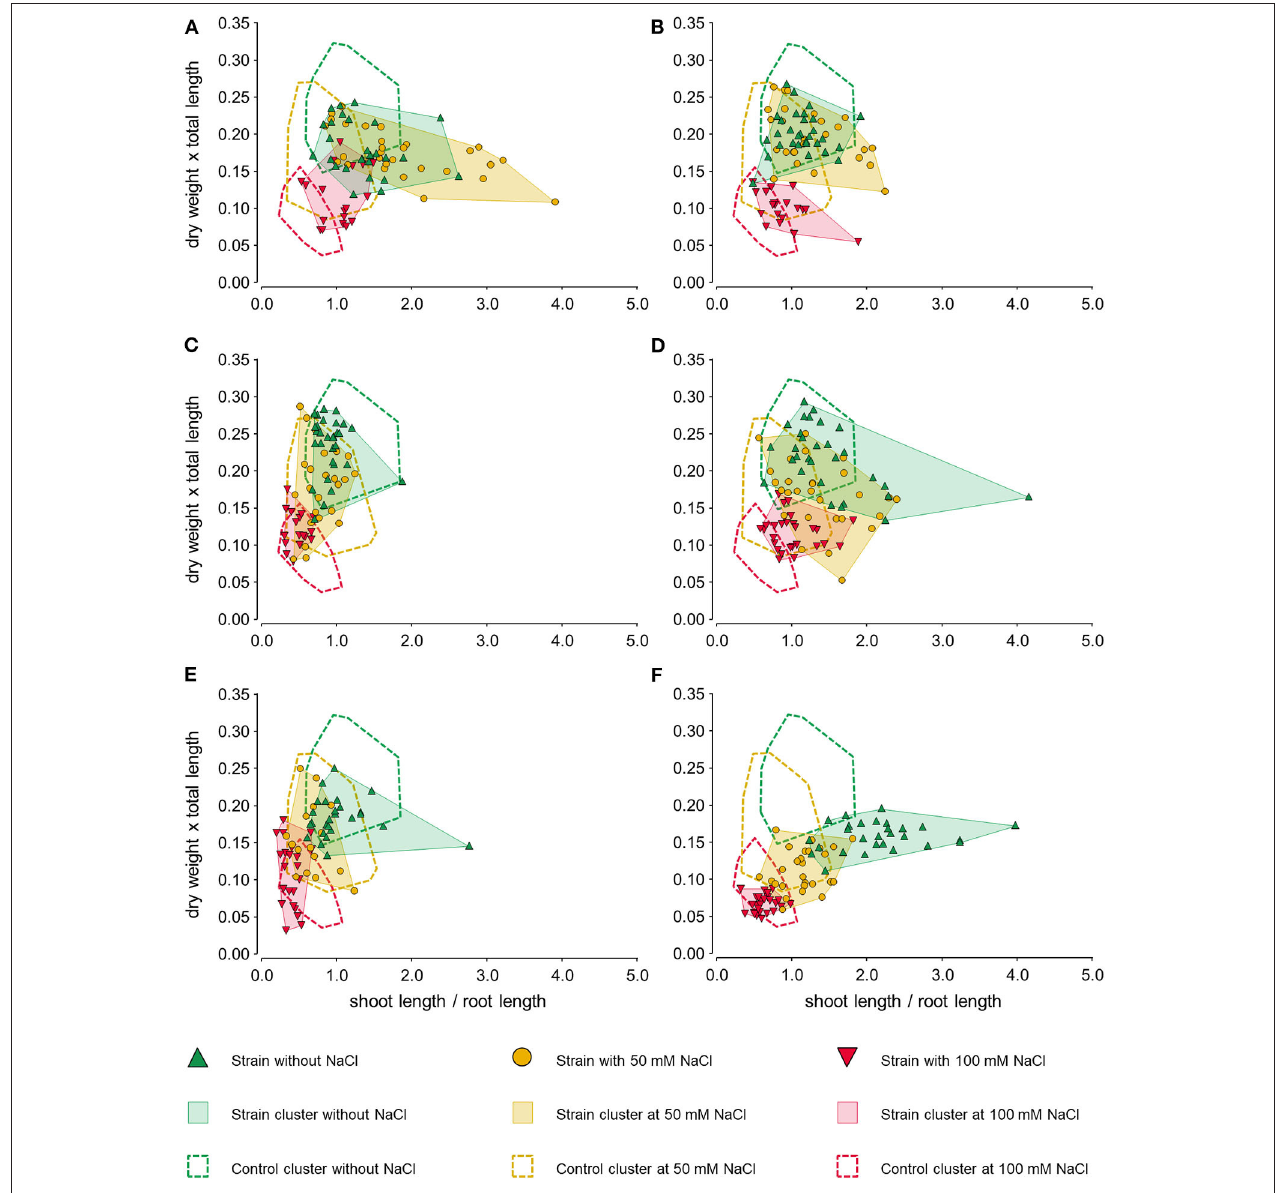
FIGURE 6 | Scatter plots relating the ratios of growth variables of the 7-day-old chia ( Salvia hispanica L.) seedlings grown on MS/2 agar with different saline conditions: without salt, with 50 and 100mM NaCl. The seedlings grew in the presence of six bacterial strains, being the treatments: (A) Kushneria sp. T3.7, (B) Halomonas sp. 3R.12, (C) Pseudomonas sp. AN21, (D) Pseudomonas sp. AN23, (E) Planomicrobium sp. 3S.31, and (F) Pseudarthrobacter sp. ER25. Values were transformed with respect to the mean values of the Control treatment without bacteria and without salt. Areas with dashed-line borders show the cluster distribution of the control treatment (without bacteria) for each saline